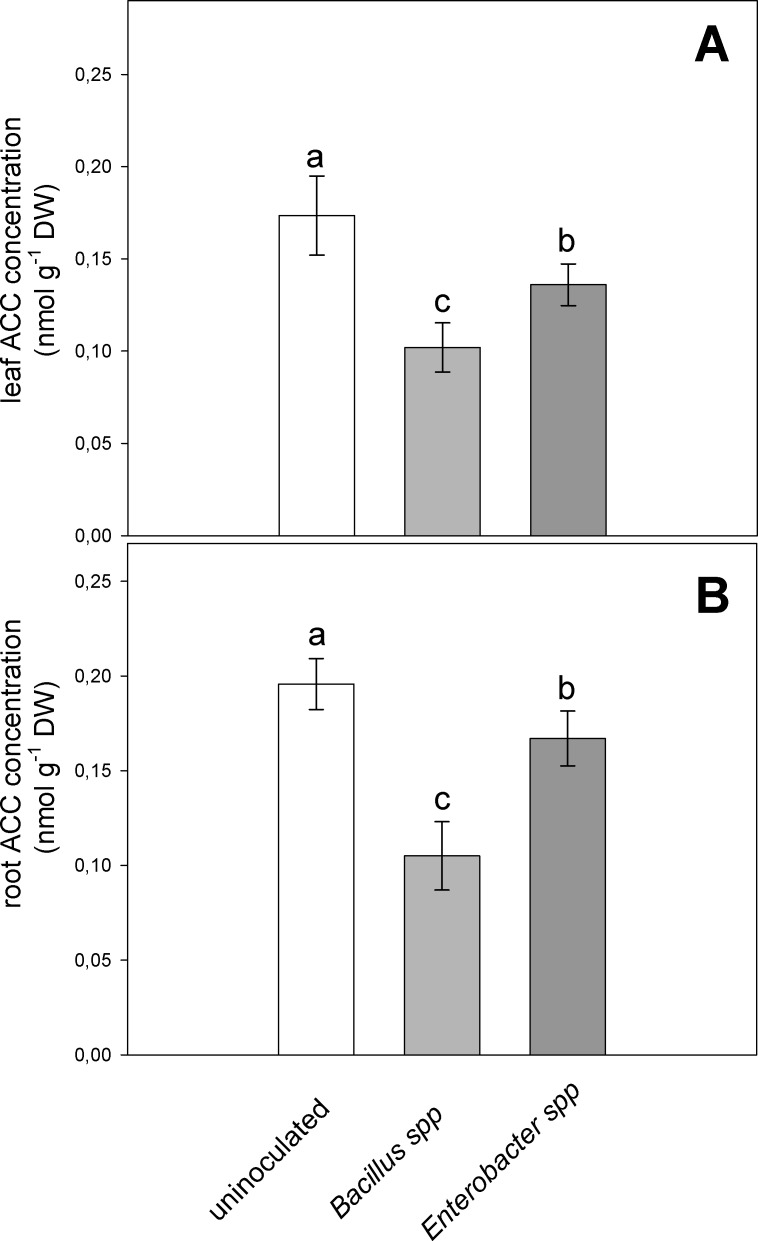
Effect of severe water stress (FSTW10) on ACC (1-Aminocyclopropane-1-carboxylate) concentration in leaves (A) and roots (B) of velvet bean plants grown in soil inoculated with Enterobacter spp. and Bacillus spp., or uninoculated. Values are means of five plants ± SE, letters indicate significant differences among treatments (P < 0.05).